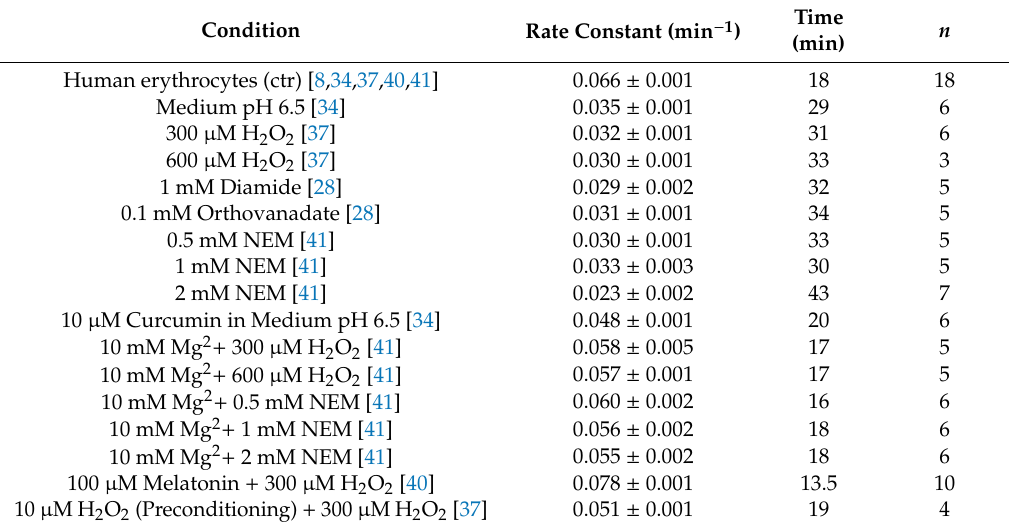
Table 1. Rate constant (min − 1 ) for SO 4 =